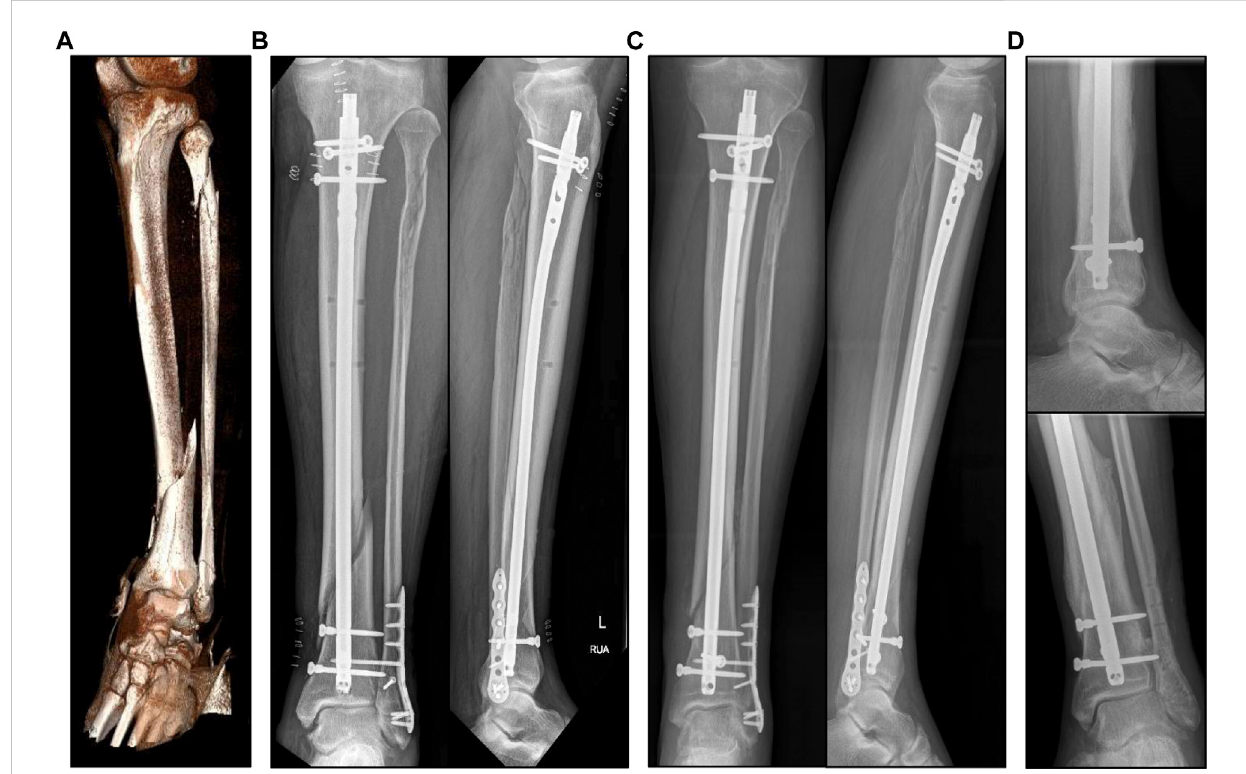
FIGURE 1 (A) : 3D reconstruction of the injured lower leg showing diaphyseal distal tibia fracture and a proximal and distal fi bula fracture. (B) : X-rays antero- posterior and lateral view after surgical intervention by intramedullary nailing and plate osteosynthesis of the distal fi bula fracture. (C) : X-ray